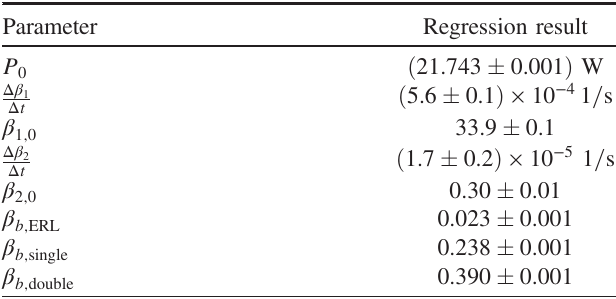
TABLE II. Table of the obtained parameters in a curve fit using the analytical rf power model.